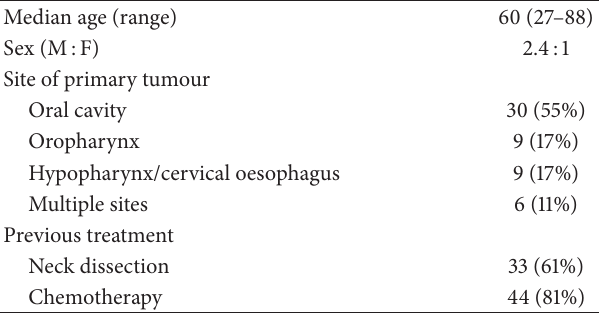
Table 1: Patient demographics and clinical characteristics ( 𝑁 = 54 ).